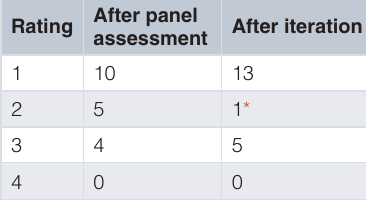
Table 2. Summary of outcome of the Scientific Development Group